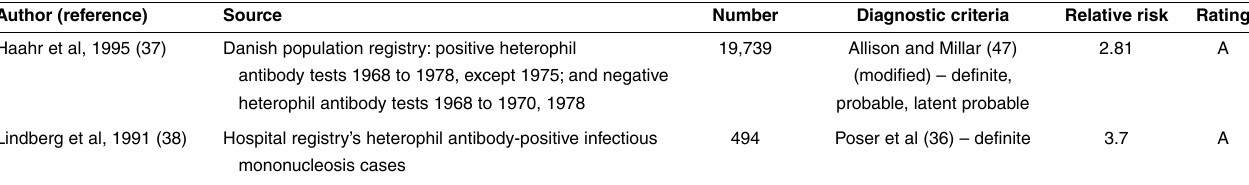
TABLE 5 Historical cohort